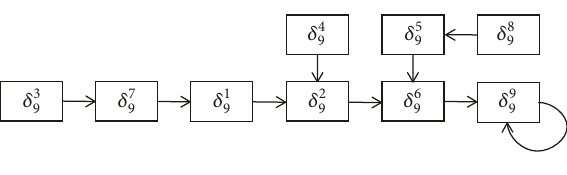
Figure 6: Basin diagram of NFSR2 in Example